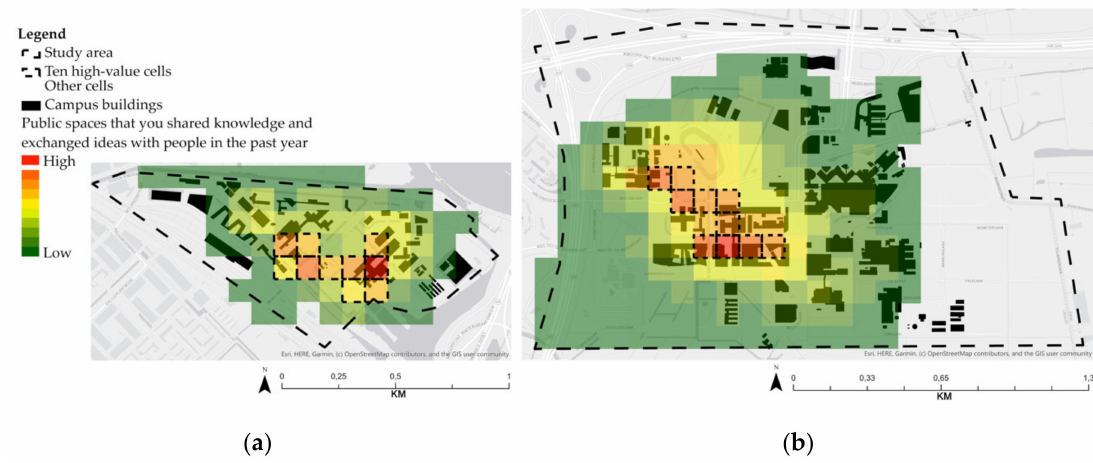
Figure 10. Results of VGI data for science parks: ( a ) Amsterdam; ( b ) Utrecht. Table 5. Grid cells with the highest frequency of creative